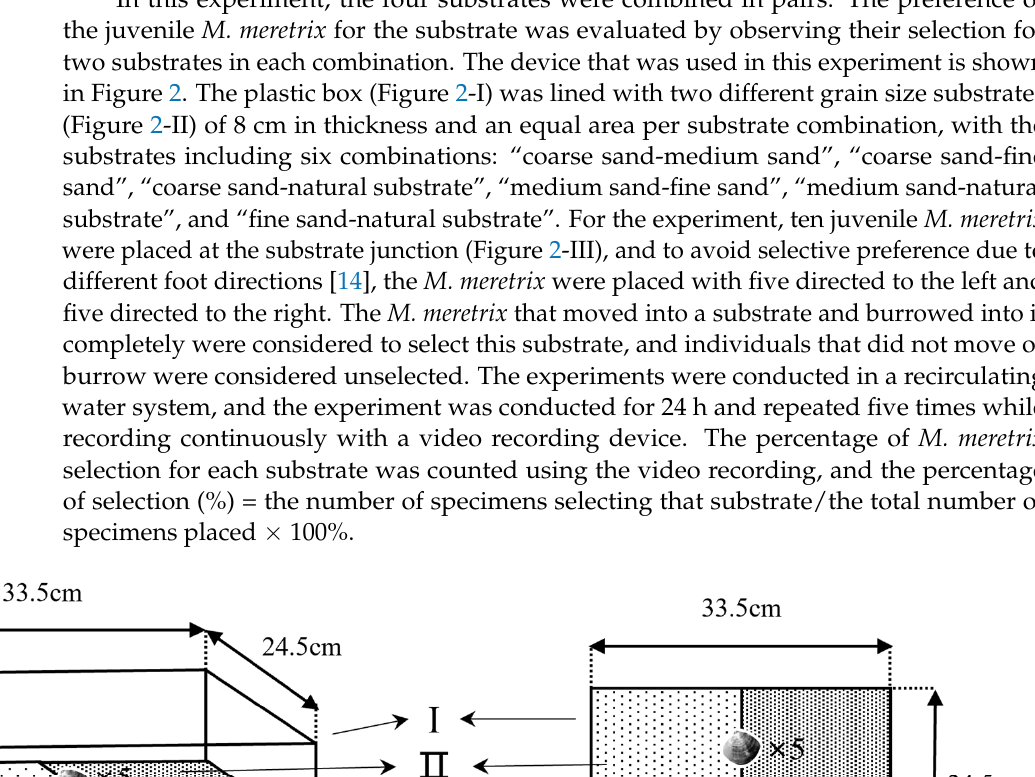
Figure 1. The experimental device for the burrowing ability.